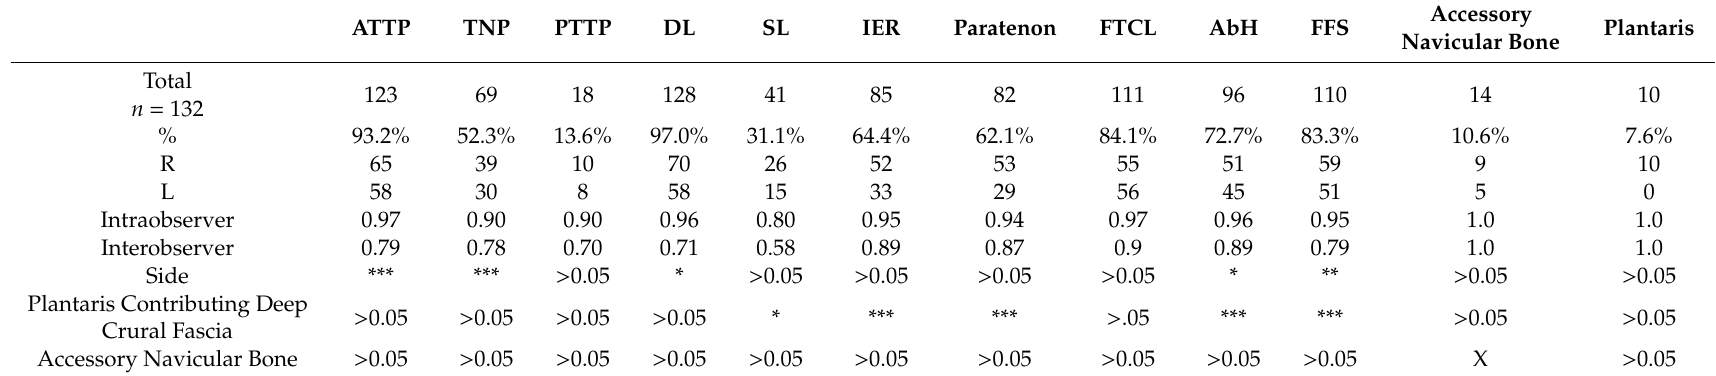
Table 1. Number of connections of FR with other structures included in the study. p values for the di ff erences in the number of connections in the groups of patients with plantaris tendon type 4 and with accessory navicular